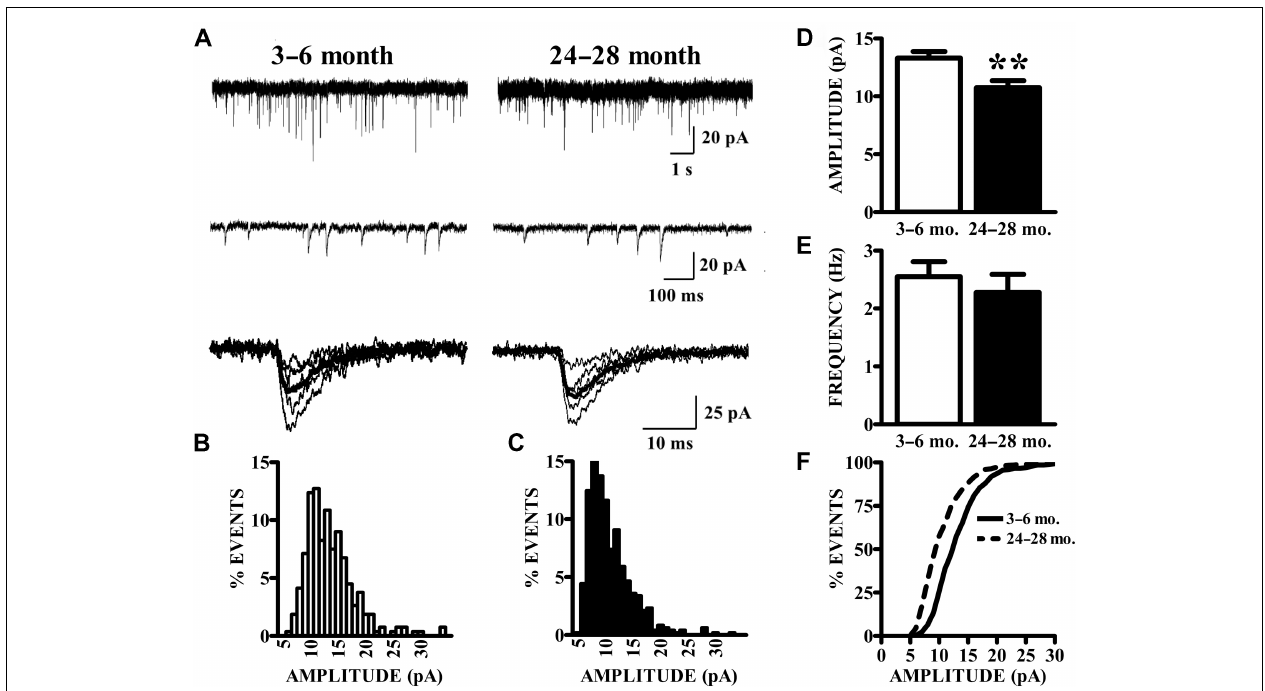
old (24–28 months) animals (C) demonstrated a leftward shift in distribution as compared to young (3–6 months) animals (B) . (D) Mean amplitudes (shown) of AMPA mEPSCs were significantly decreased in old relative to young mice ( t 36 = 2.87, p < 0.01). Comparison of both age groups according to the median amplitude (not shown) also demonstrated a reduction. (E) The frequency of mEPSCs was comparable between age groups. Frequency was determined by counting the events that occurred during the entire 200-s recording epochs. (F) Cumulative distributions illustrate the shift in the mEPSC